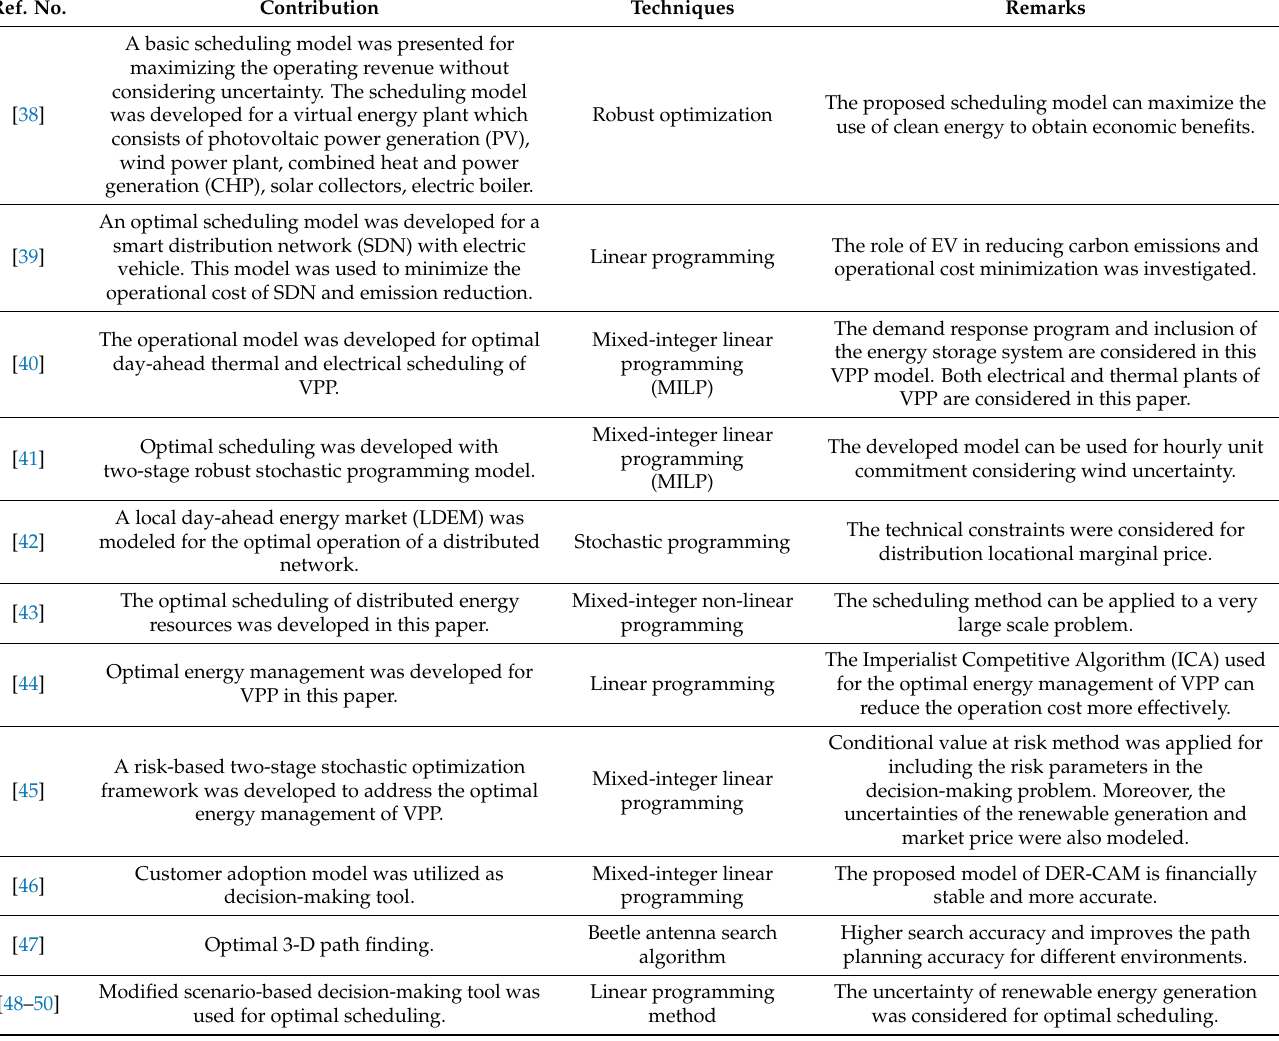
Table 1. Literature survey of Virtual Power